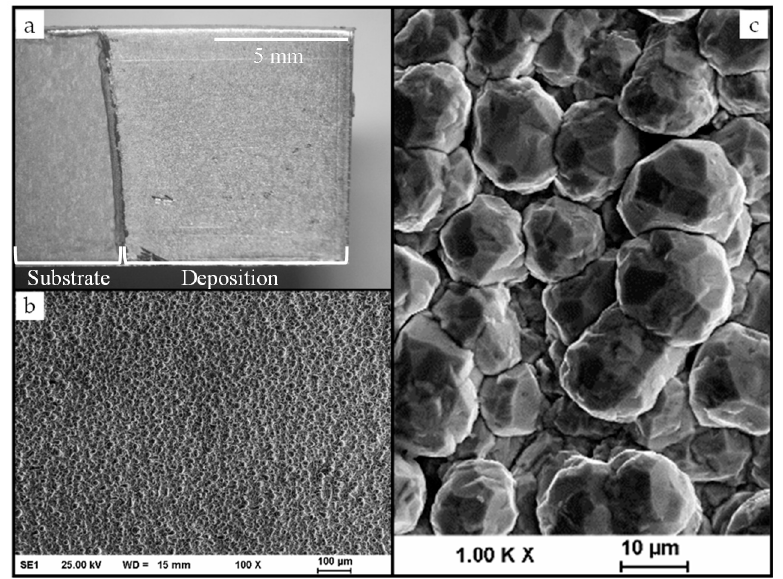
Figure 3. Deposition of a Cu − Sn alloy on steel substrate ( a ) and scanning electron microscopy (SEM) images ( b , c ) with different magnifications of the surface of a Cu − Sn layer (0.5 A/dm 2 , 95 °C, 100 rpm, 10,800 s) with 85% mass fraction of copper deposited outside the glove box.